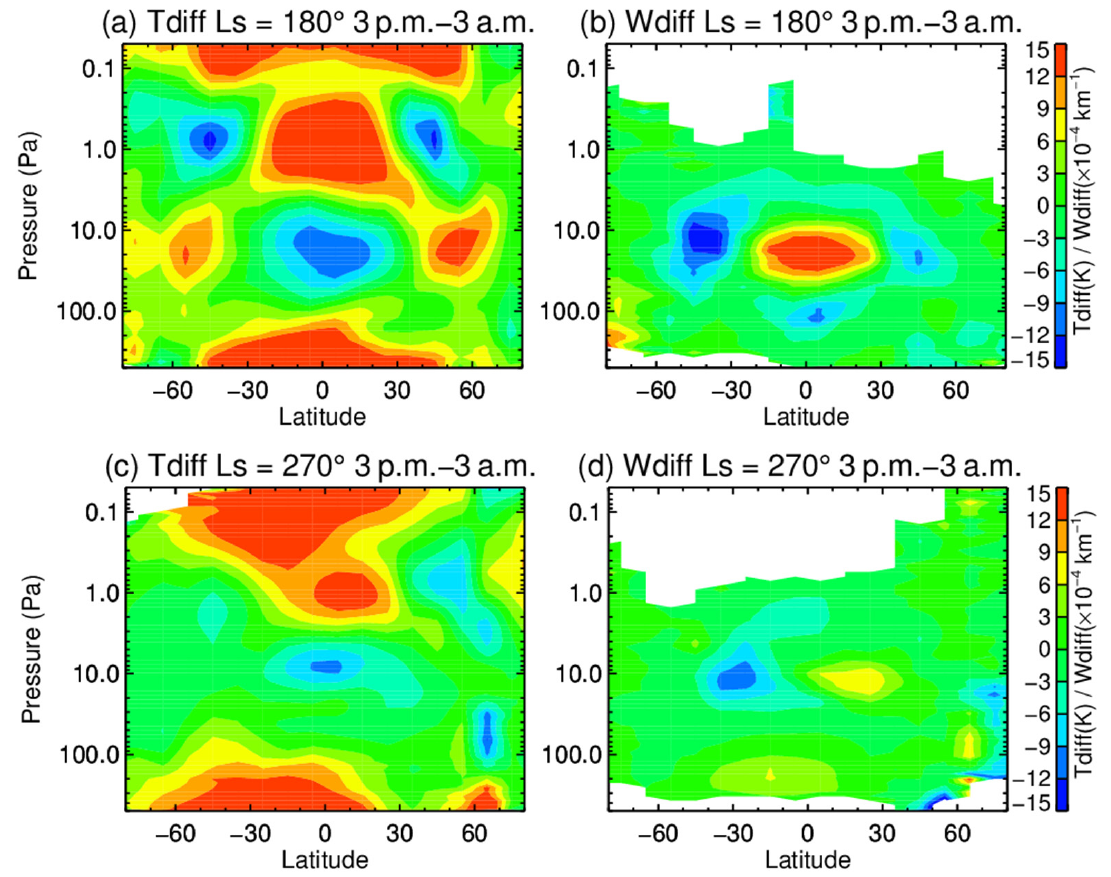
Figure 3. The differences between 3 p.m. and 3 a.m. in the temperature ( a , c ) and water ice opacity ( b , d ) at the northern fall equinox ( a , b ) and northern winter solstice ( c , d ).